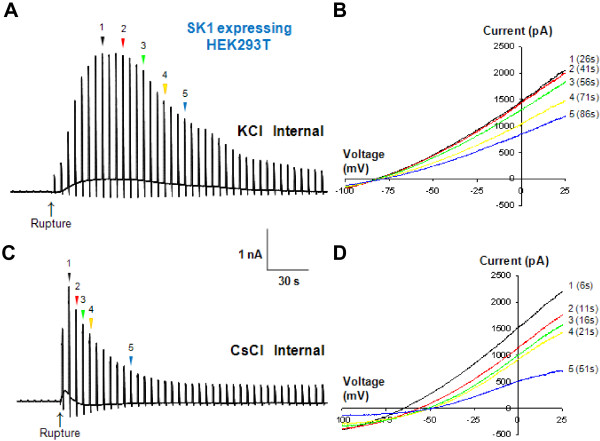
TFLLR-induced conductance is mediated by Best1 channel in hippocampal CA1 astrocytes. A. Representative current responses induced by whole-cell patch clamp from HEK293T expressing hSK1 using KCl-containing pipette solution (n = 8). The current responses were recorded in response to a voltage ramp command (from -100 to +100 mV, 1 s duration, 0.2 Hz; Vh of -60 mV. Internal pipette solution is composed of (mM) 150 KCl, 10 HEPES, 1 CaCl2, 1 MgCl2, and 5 EGTA (100 nM free Ca2+). B. The 5 selected representative current–voltage relationships recorded from a). C. Representative current responses induced by whole-cell patch clamp from HEK293T expressing hSK1 using KCl-containing pipette solution (n = 7). D. The 5 selected representative current–voltage relationships recorded from c). Averaged time that Er reaches to plateu from rupture is 63.4 ± 14.6 s (n = 7).